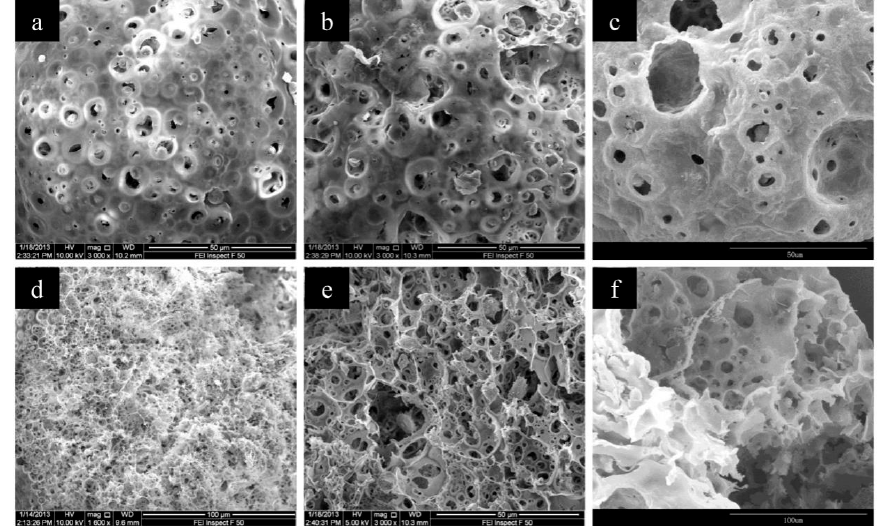
Figure 5. The SEM images of CMC/CA microspheres fabricated with 2% ( a , d ), 3% ( b , e ), 4% ( c , f ) CMC concentrations. Images ( a – c ) were the surface images while ( d – f ) were the cross-section images of CMC/CA microspheres.